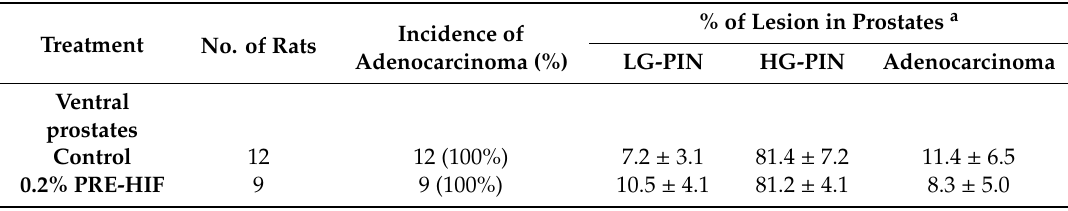
Table 2. Incidence of carcinoma and quantitative evaluation of prostatic neoplastic lesions in TRAP rats treated with